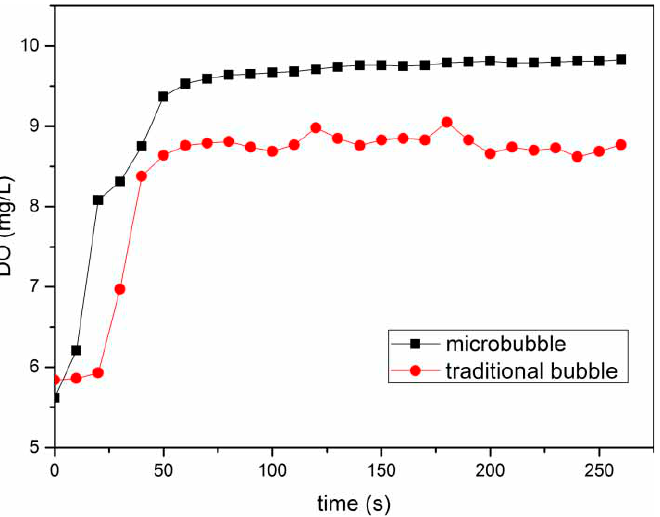
Figure 7. Variation in DO concentration at a gas flow rate of 0.67 L/min [118]. (DO—dissolved oxygen). Reprinted with permission from Ref. [118].